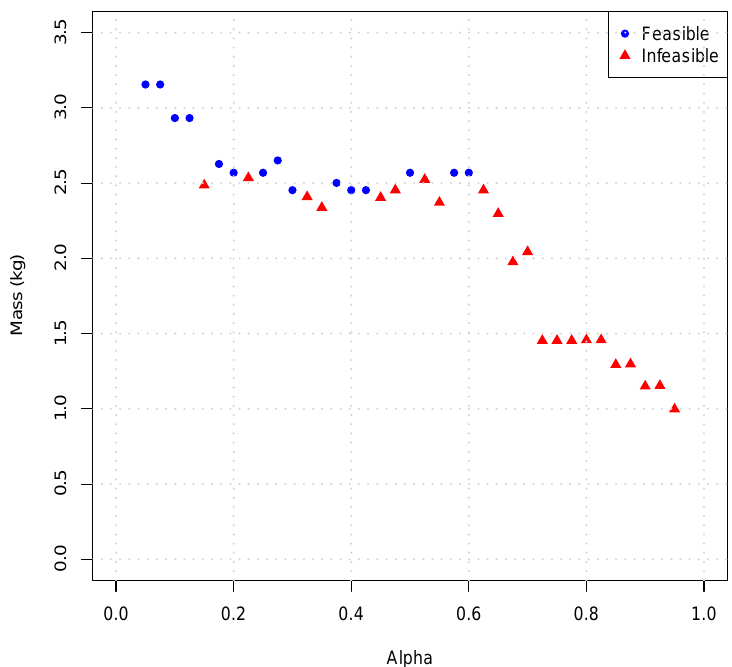
Figure 21. Second DOE: optimum mass for different α values computed by the FE